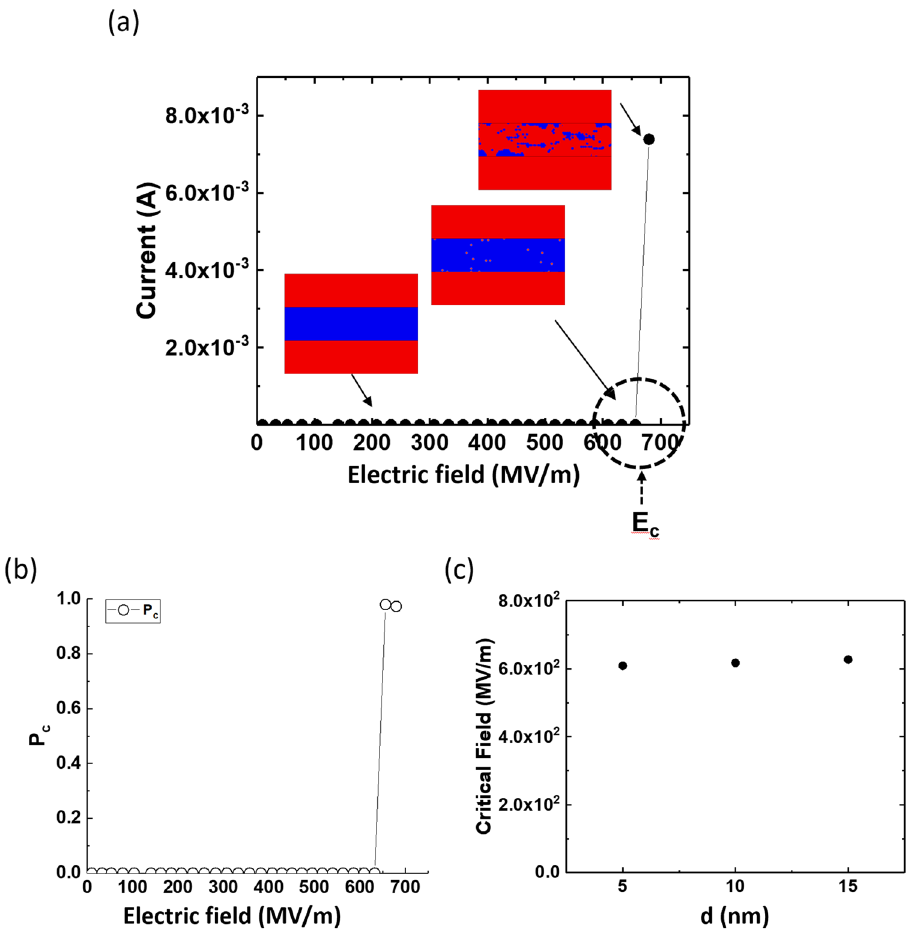
Figure 4. Simulation results for defect-free systems with no interface roughness and no initial defects: ( a ) current and ( b ) defect-generation probability as functions of the applied electric field for 5-nm-thick HfO 2 device, and ( c ) critical electric field as a function of the HfO 2 thickness. Insets in ( a ) show the phase distributions at three applied electric fields. The red region denotes the LRP that includes the top and bottom electrodes, and dark blue denotes the